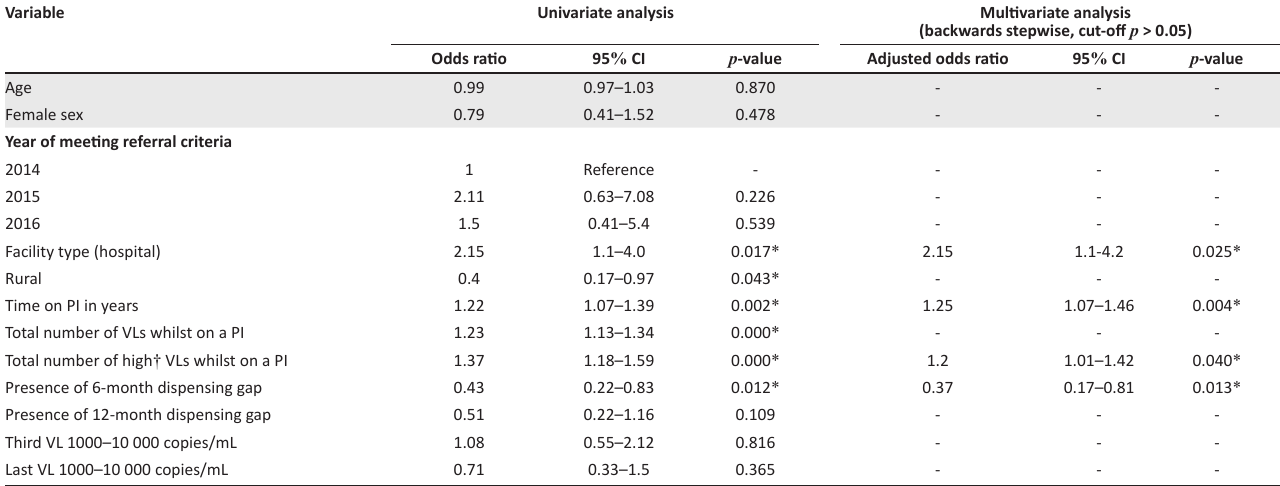
TABLE 3: Predictors of referral. Univariate and multivariate analysis.